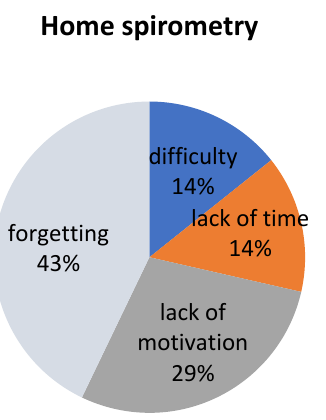
Figure 3. Reasons for irregular measurements of home spirometry reported by participants.